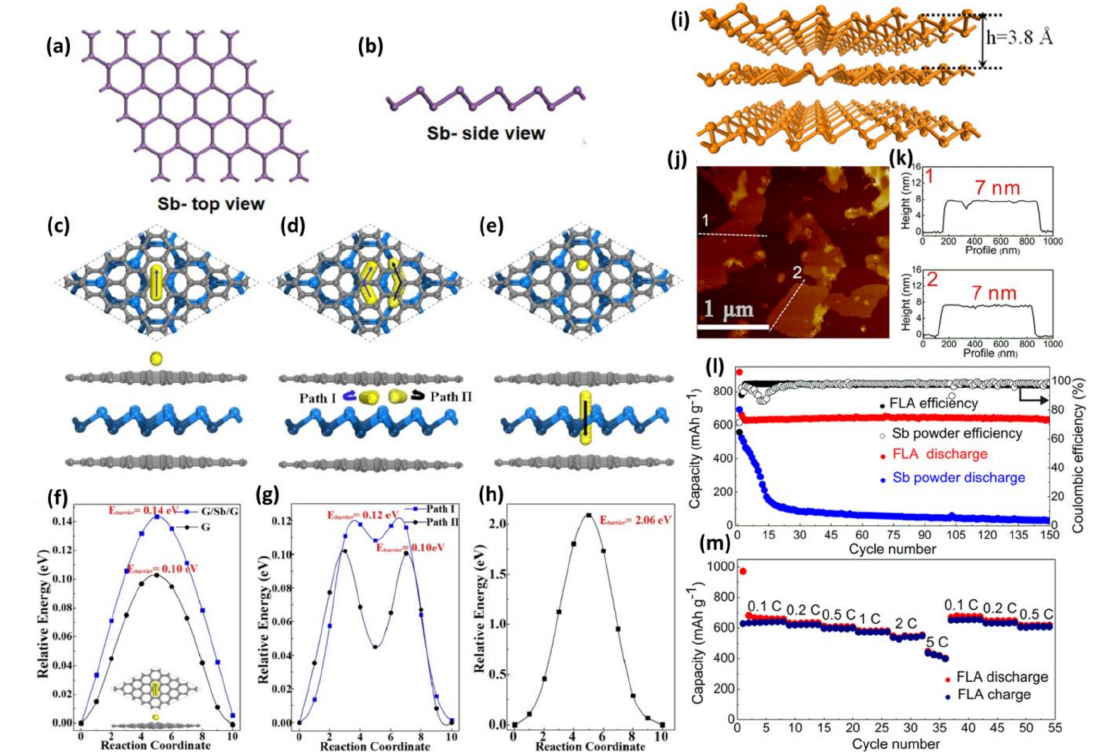
Figure 4. ( a , b ) 3D representation of the structures of monolayer antimone. Diffusion pathways and energy barriers of Na diffusion: ( c , f ) Outside of the graphene surface, ( d , g ) interlayer of the heterostructure, ( e , h ) across over the antimonene layer, the grey, blue and yellow spheres represent C, Sb and Na atoms, respectively. ( i ) Atomic structure illustration, ( j ) AFM image, ( k ) profile terraces of few-layer antimonene ( l ) Long-term cycling performance of the few-layer antimonene and bulk Sb powder at a rate of 0.5 C. ( m ) Rate capability of few-layer